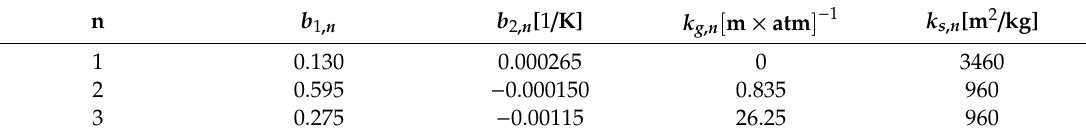
Table 3. Spectral constants in the mixture of gas and soot emissivity equation [39].